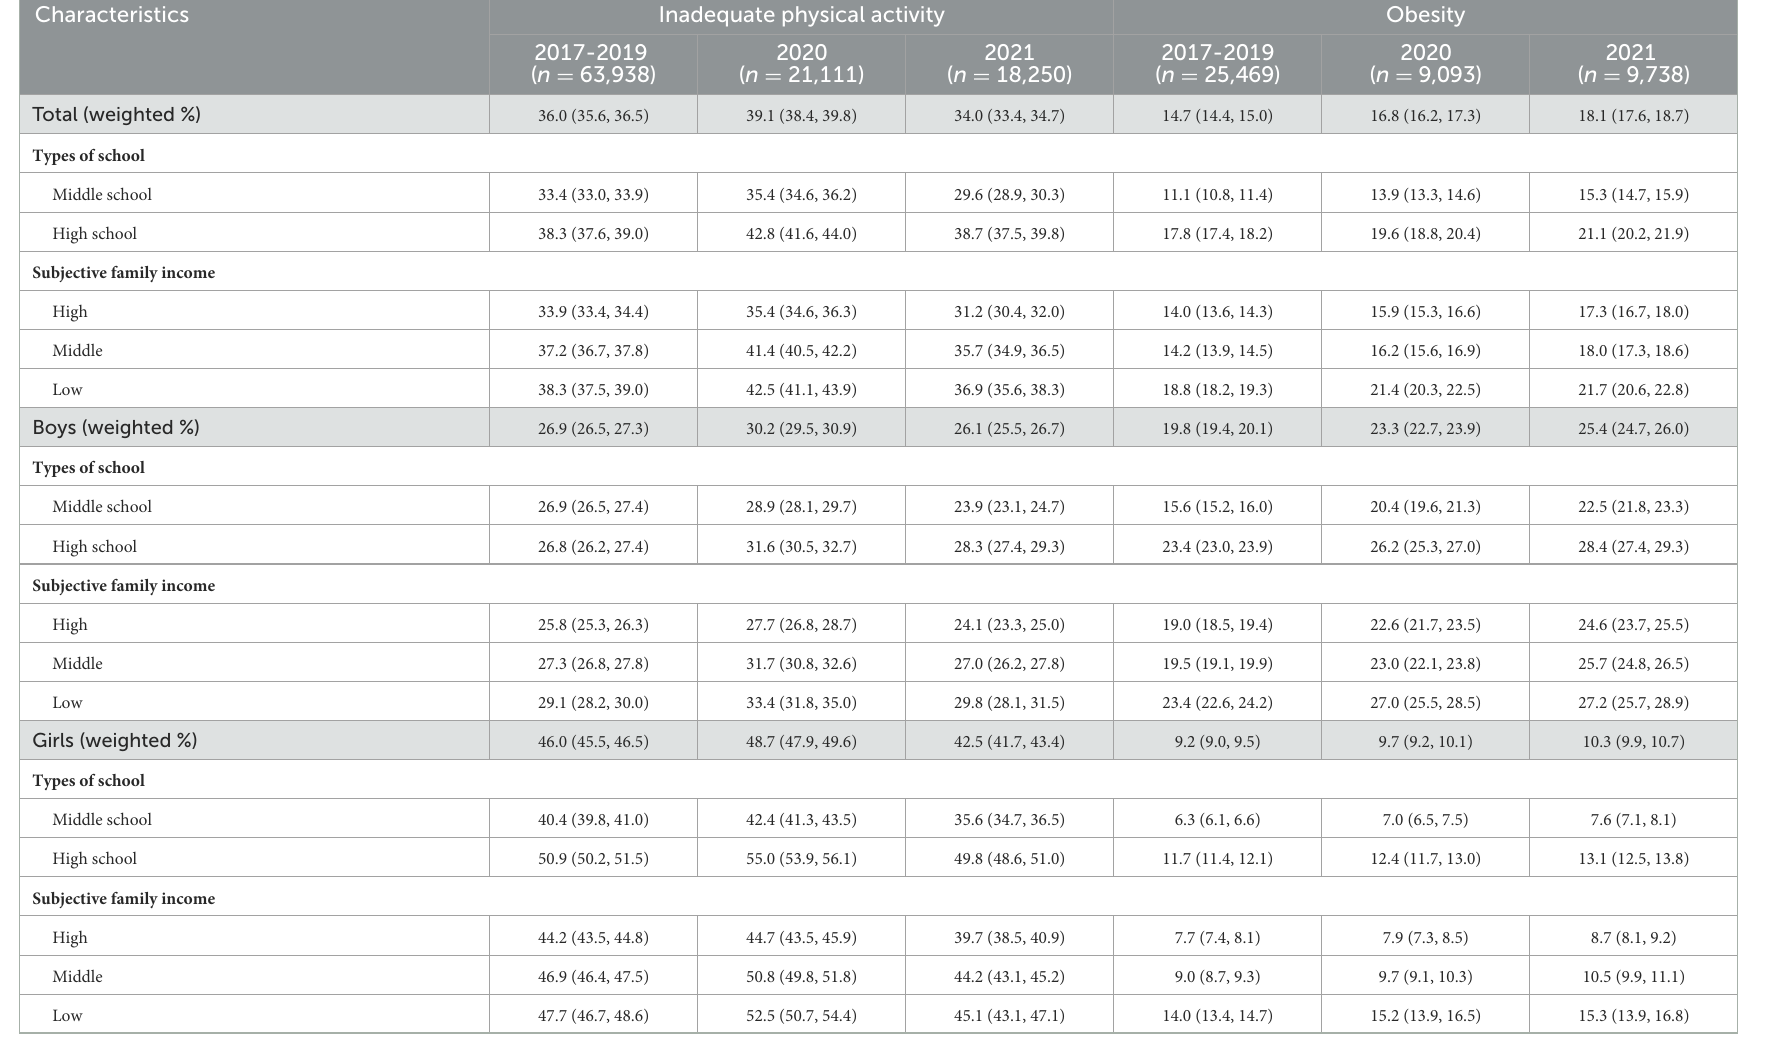
TABLE 3 The weighted prevalence of inadequate physical activity and obesity in the KYRBS 2017-2019, 2020, and 2021 samples.